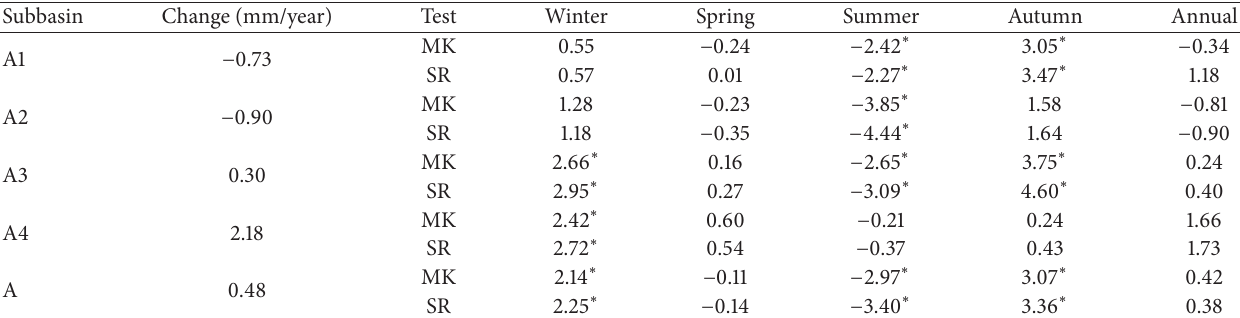
Table 6: MK and SR results for seasonal and annual precipitation time series in entire basin and subbasin of Swat River. Subbasin Change